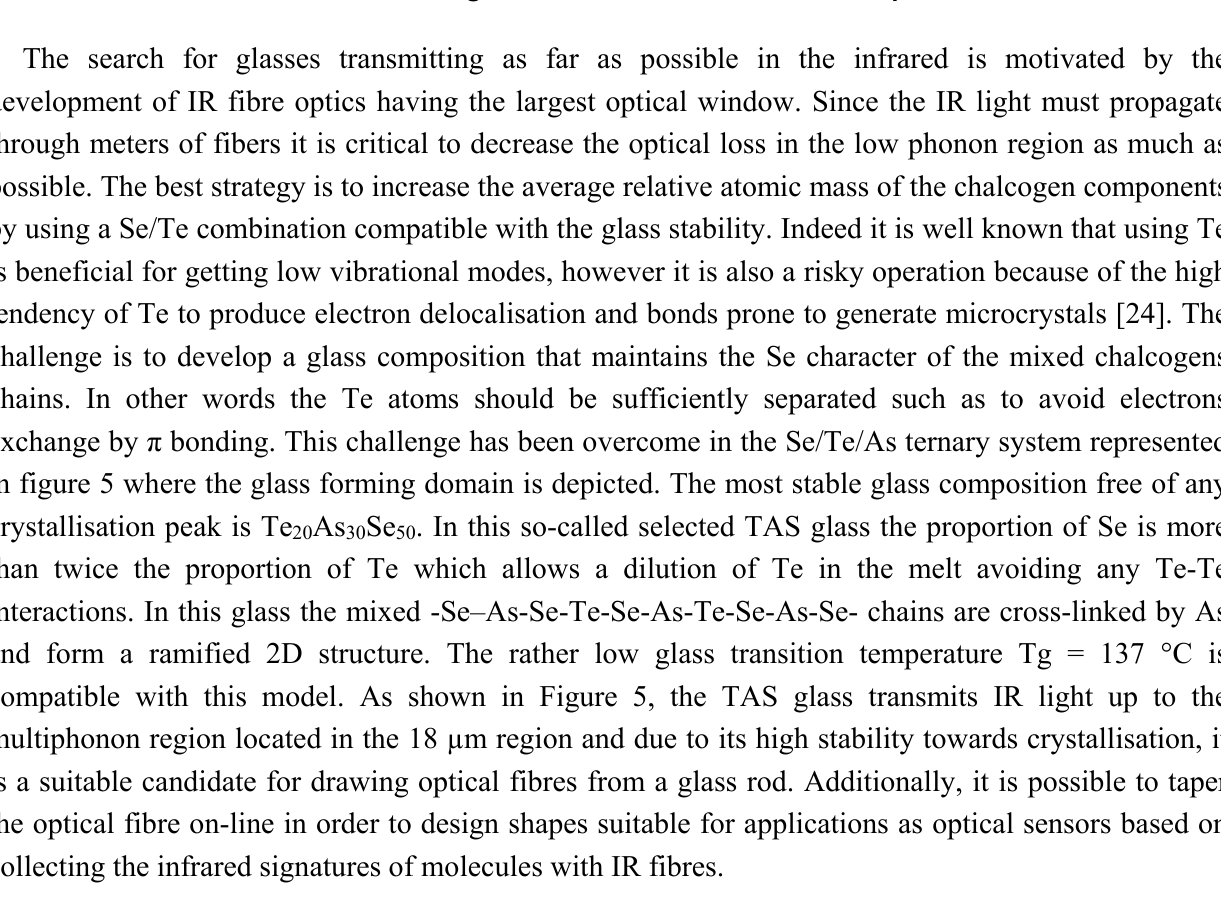
As Se composition (called TAS glass). The 2 3 5